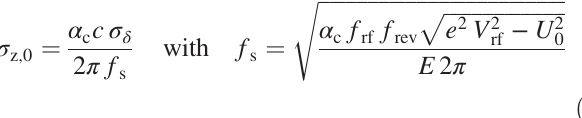
ffiffiffiffiffiffiffiffiffiffiffiffiffiffiffiffiffiffiffiffiffiffiffi p e 2 V 2